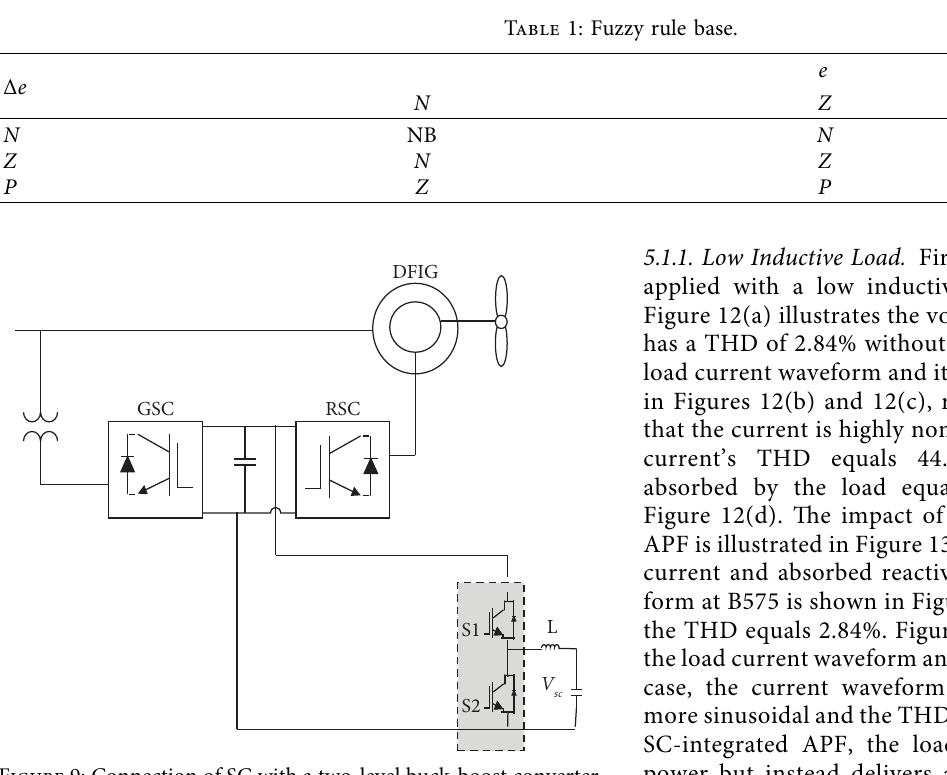
Figure 9: Connection of SC with a two-level buck-boost converter to the DFIG.